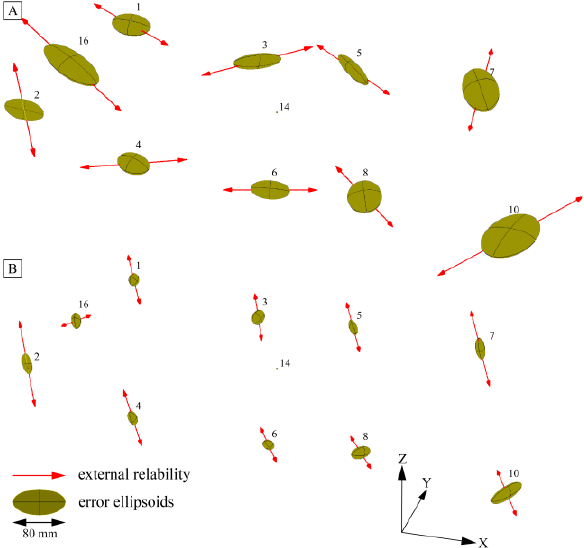
Fig.6: Error ellipsoids and external reliability indicators for the long (A) and short (B) pole configurations (same scale). See text for more details.